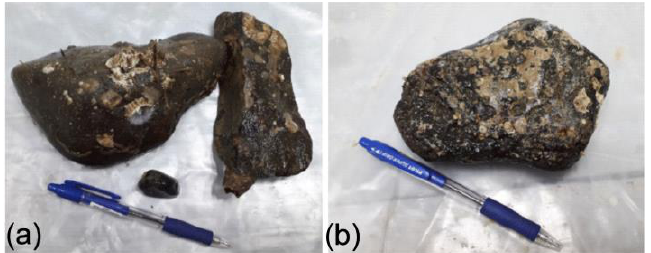
Figure 5. Coarse material from sampling points: ( a ) ANS-38-39; ( b ) ANS-38-40. Figure 2 for locations. Pen is for scaling, 14 cm.